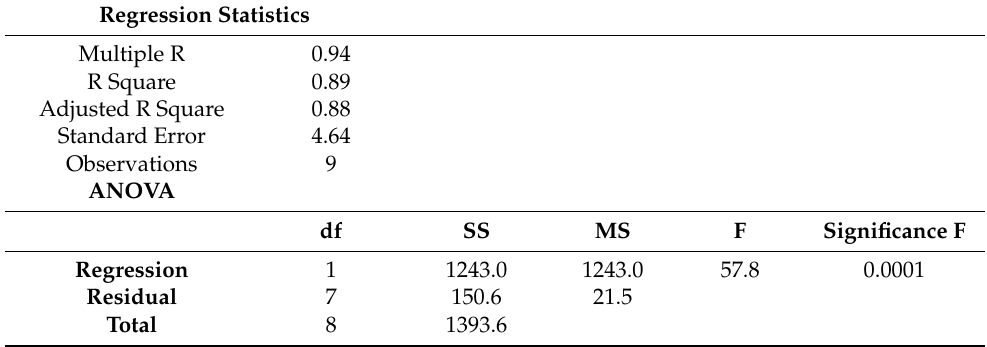
Table 7. Summary output regression statistics analysis comparing breakdown between obstacles identified by university teachers and students.